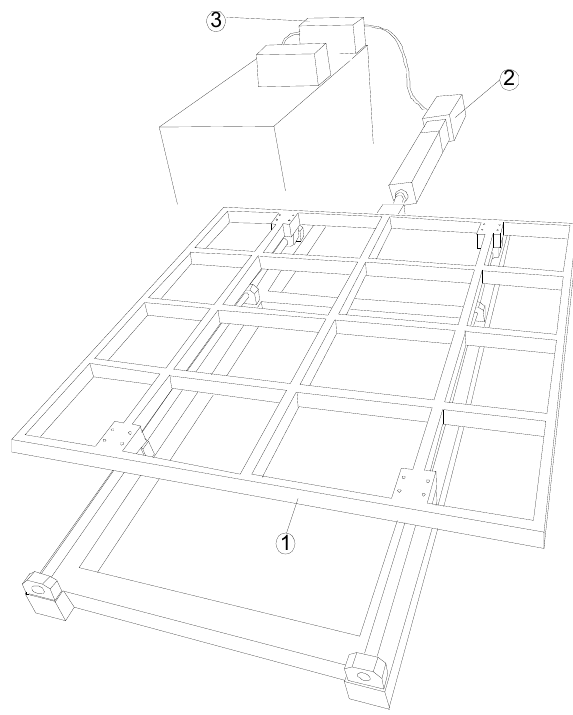
Figure 6. Technical sketch of the experimental setup (1: middle-sized shaking table platform, 2: linear actuator, 3: actuator controller).